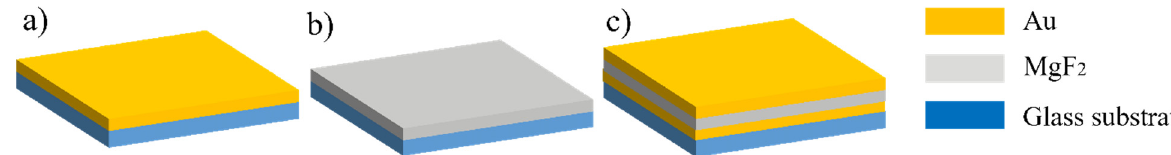
Figure 9. The diagram of Samples: ( a ) Au single layer deposited on a glass substrate; ( b ) MgF 2 single layer deposited on a glass substrate; ( c ) Au-MgF 2 -Au film stacks deposited on a glass substrate.